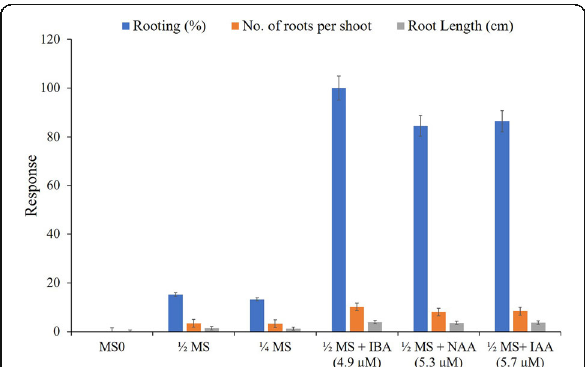
Fig. 3 Effect of nutrient strengths of MS medium and auxins on root